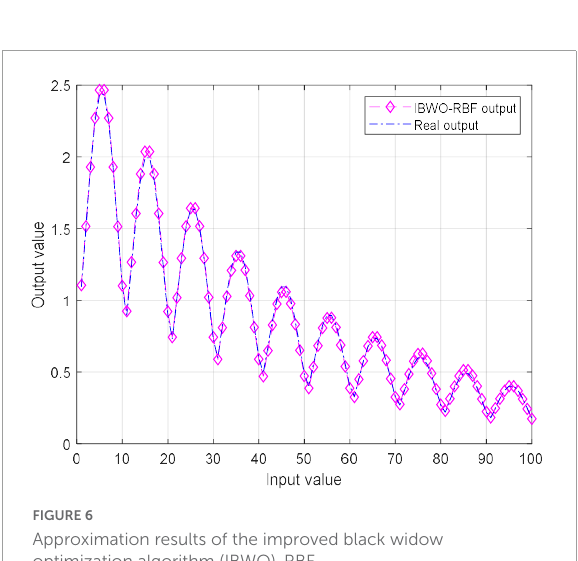
FIGURE5 MSE value of the improved black widow optimization algorithm (IBWO)-RBF.